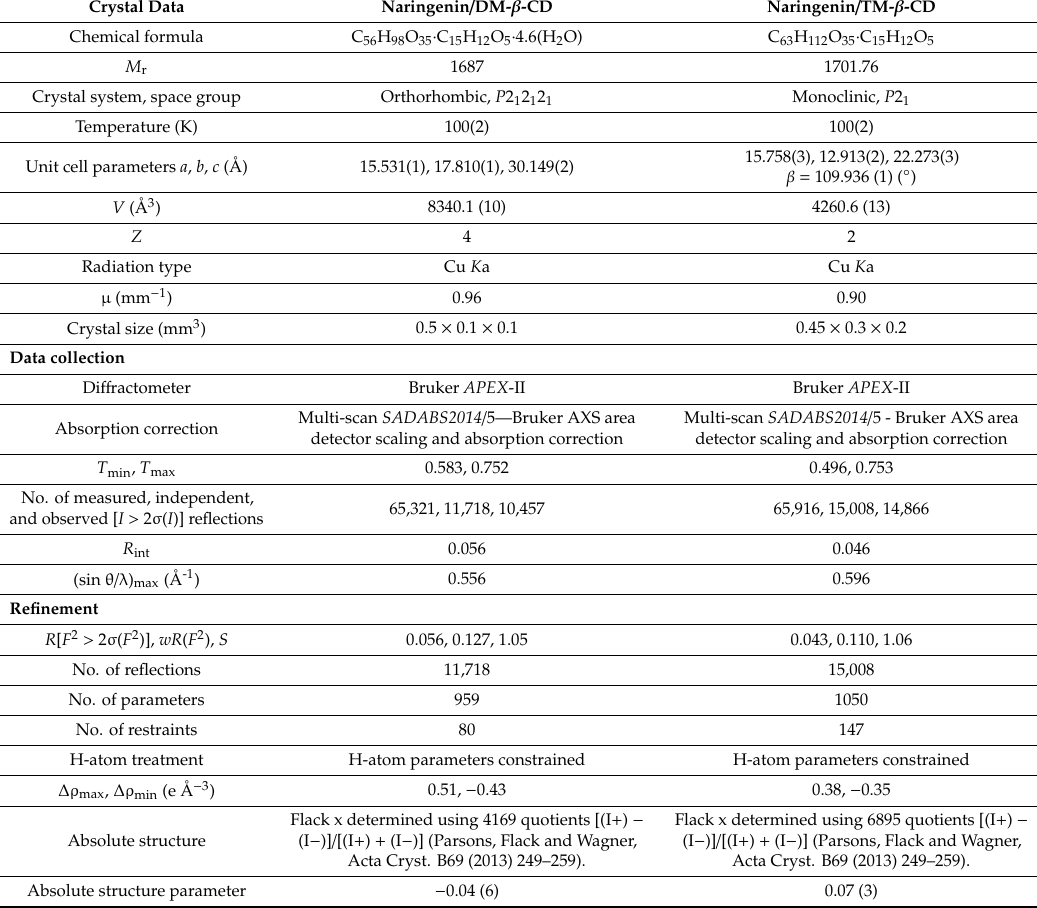
Table 2. Experimental details and refinement